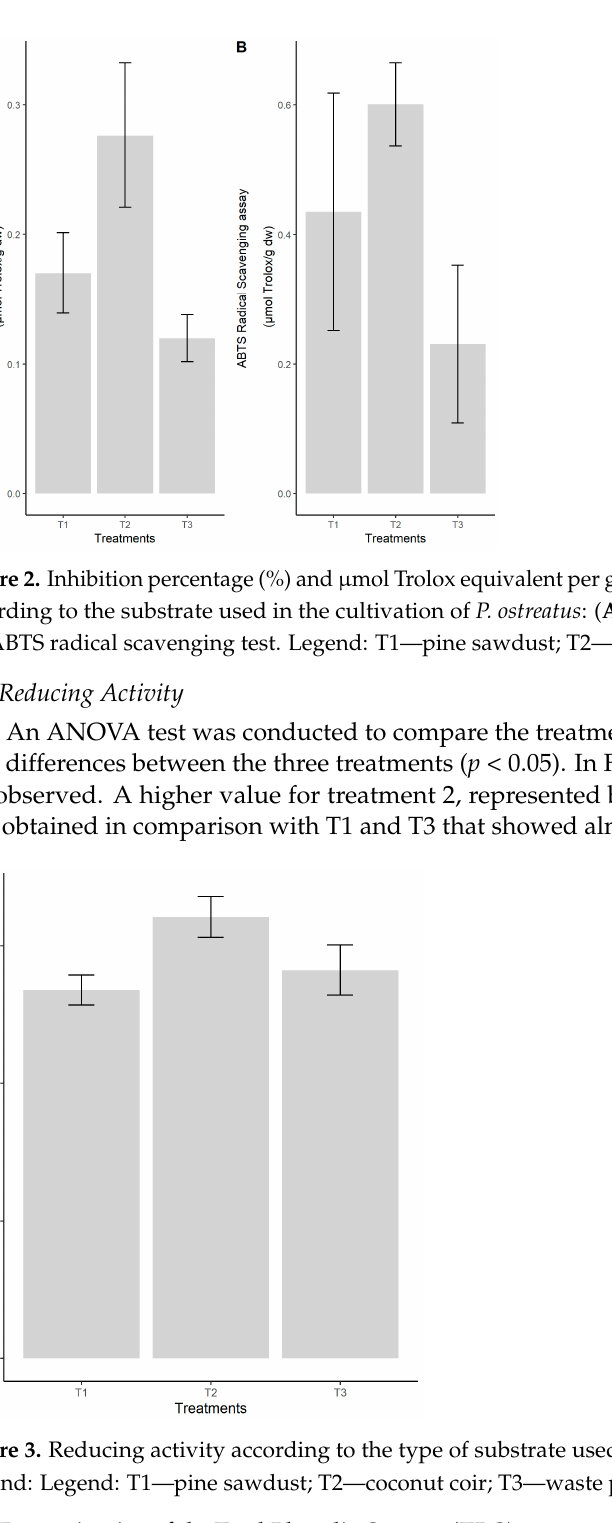
8 of 20 Figure 1. Mushroom Growth analysis in function of the growth media: ( A ) Biological Efficiency (%), ( B ) Mushroom Yield (%), ( C ) Production Rate (%). Legend: T1—pine sawdust; T2—coconut coir; T3—waste paper . 3.2. Antioxidant Aptness